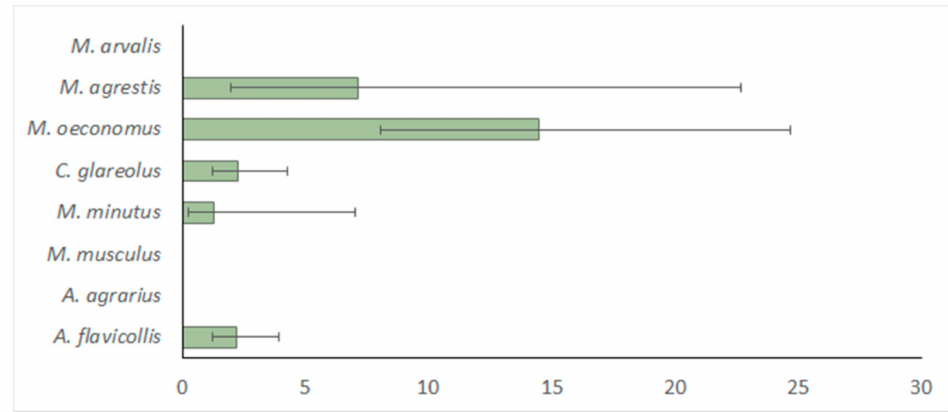
Figure 2. Prevalence (in %, bars represent 95% CI) of Babesia in the eight rodent species, irrespective to the habitat.